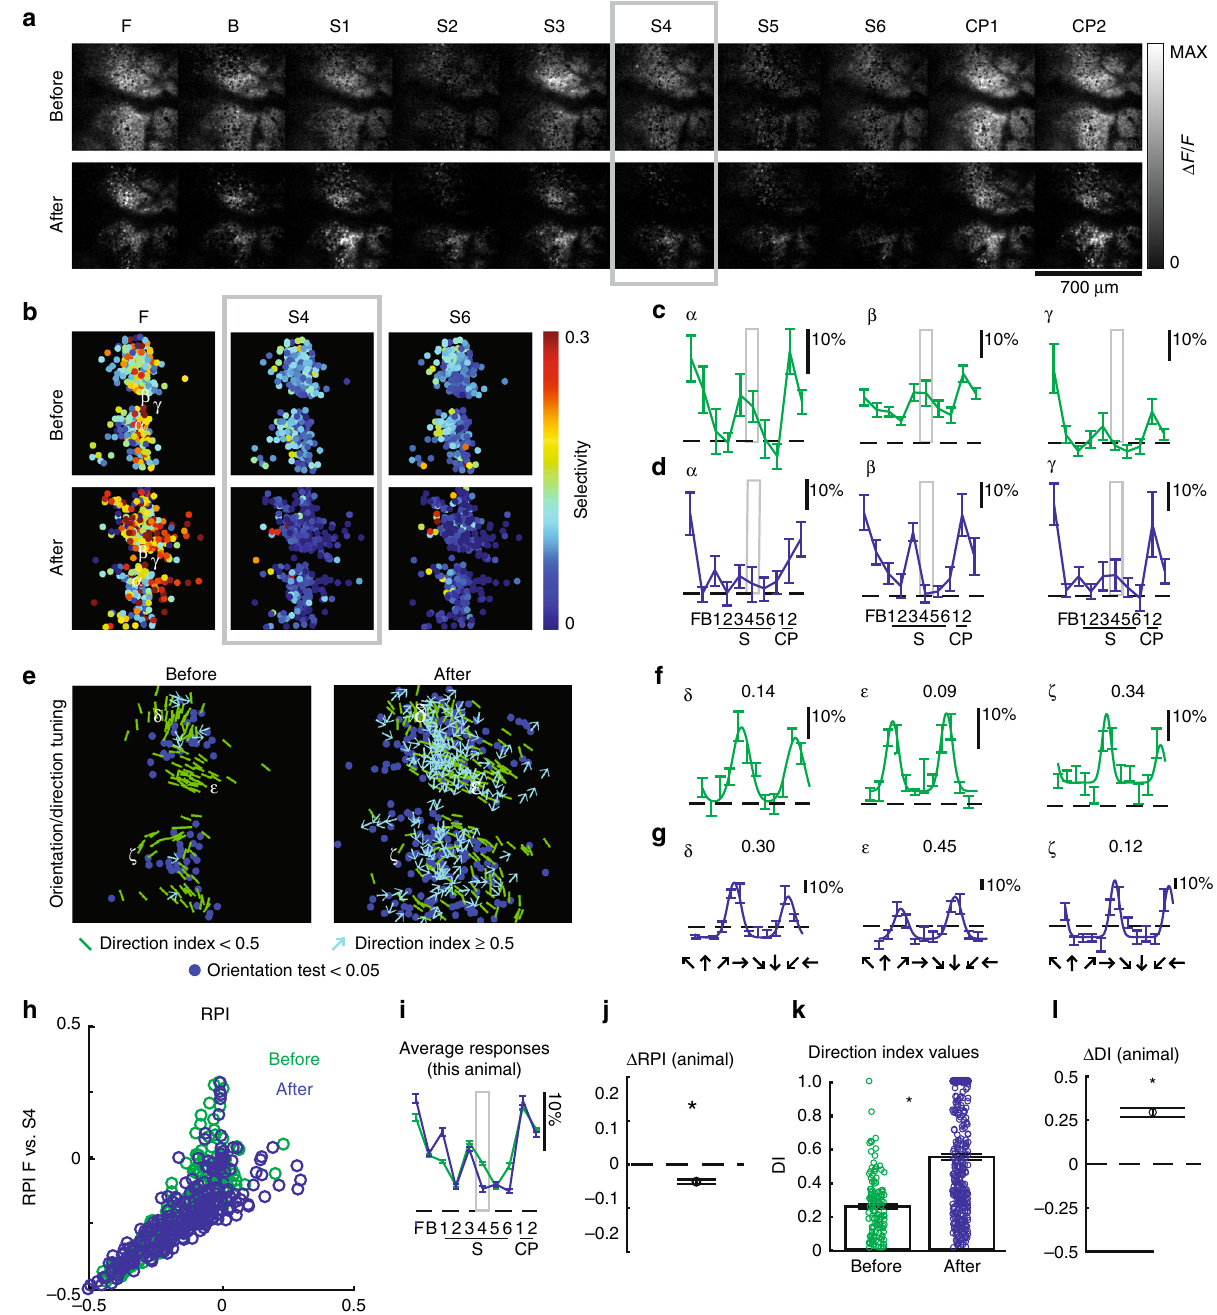
Fig. 4 In a ferret with 3 days of visual experience, 6 h of experience with a phase-scrambled grating pattern caused an increase in direction selectivity rather than selectivity for the phase-scrambled pattern. The eyes opened naturally on day P33, and the experiment was performed at P36. Panels a – l are as described in Figs. 2, 3. S4 was used as the training stimulus. In this animal, some cells were tracked across time and Greek letters appear more than once. N = 170 cells before and N = 267 cells after for measurements of F, B, S1 – 6, CP1 – 2, and N = 124 cells before and N = 371 cells after for direction tuning. This animal exhibited decreased selectivity to training stimulus S4, and exhibited a signi fi cant increase in direction